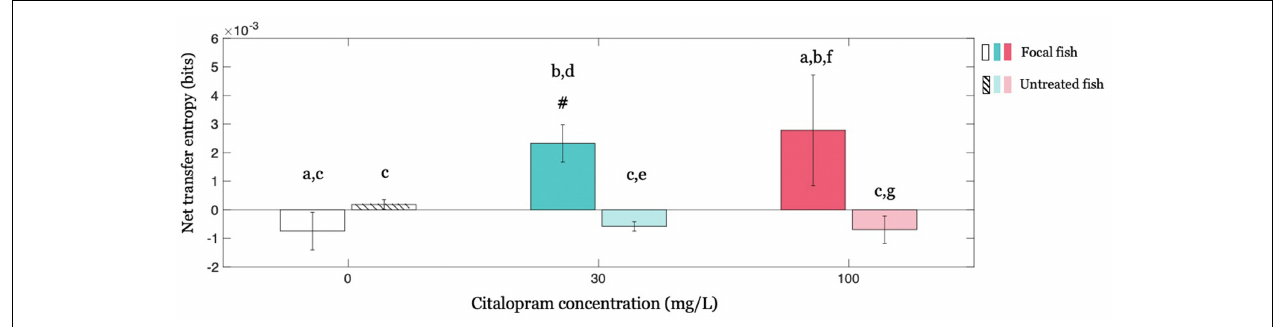
FIGURE 5 | Causal interactions within the group revealed by net transfer entropy between the focal fish and all other animals in the group for each Citalopram concentration. Positive values of net transfer entropy indicate the influence of the focal subject (treated or untreated) on the rest of the group while negative values indicate the opposite, that is, the focal subject being influenced by the others. # p < 0.050 greater than zero, and different letters indicate differences at p <